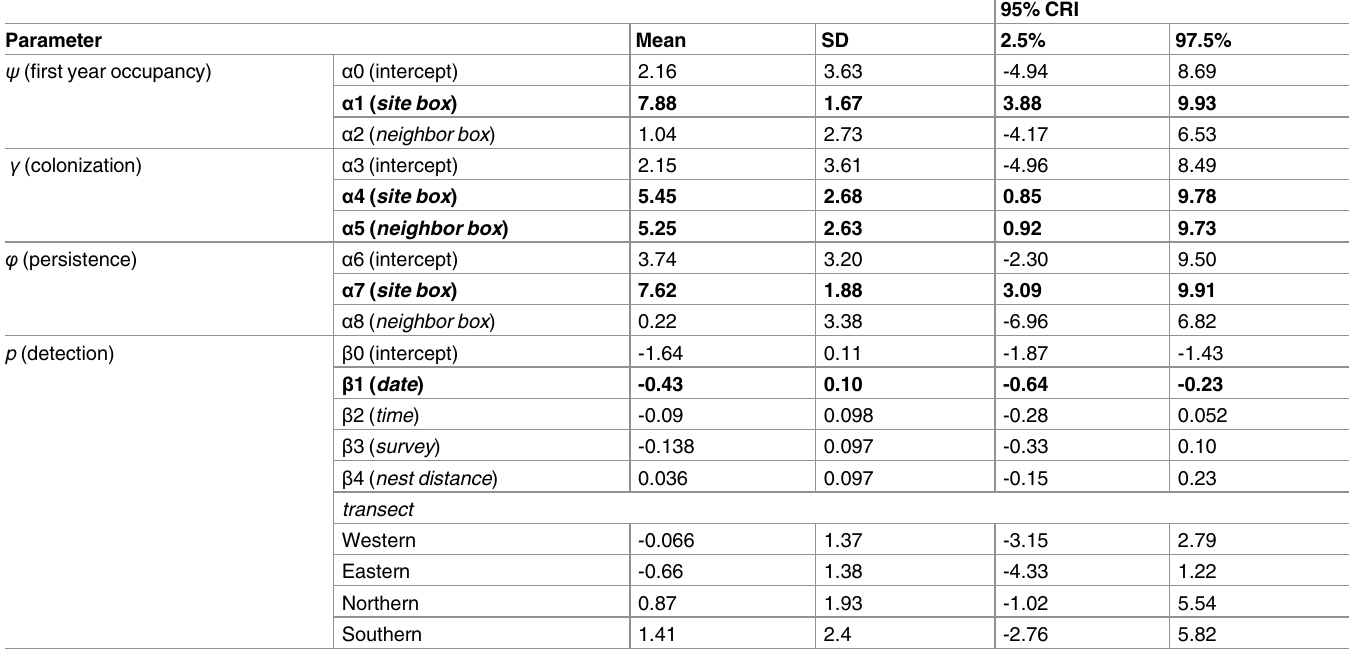
Table 1. Multi-season occupancy modeling results for kestrelpresence.